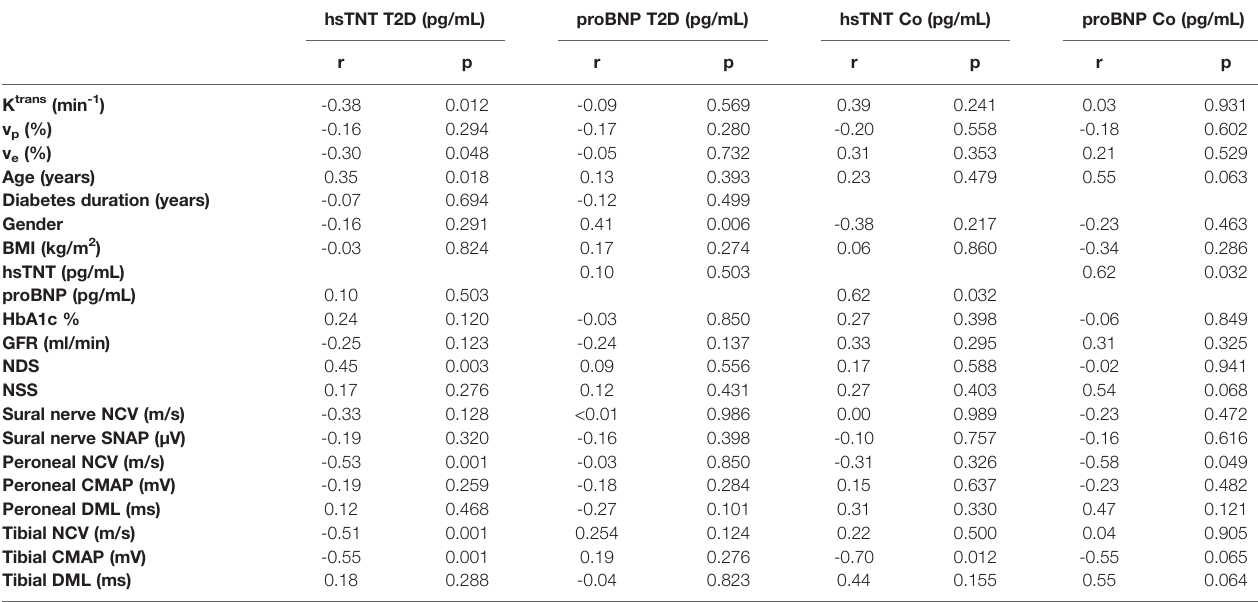
TABLE 2 | Correlations of hsTNT and proBNP with MRN perfusion parameters and demographic, serologic, clinical, and electrophysiological data. hsTNT T2D (pg/mL) proBNP T2D (pg/mL) hsTNT Co (pg/mL) proBNP Co (pg/mL)